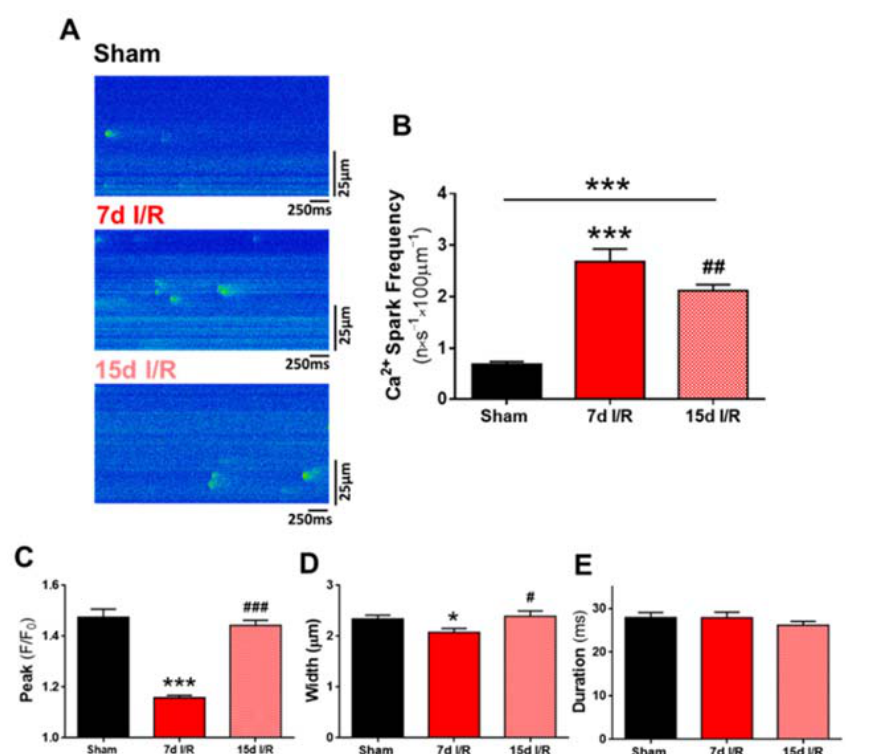
Figure 4. Diastolic Ca 2+ leak in cardiomyocytes after renal I/R. ( A ) Representative line-scan images of Ca 2+ sparks in quiescent cardiomyocytes from sham-treated mice and from mice subjected to ischemia and reperfusion (IR) for 7 and 15 days. ( B ) Frequency of Ca 2+ sparks (presented in n ∙ s − 1 ∙ 100 μ m − 1 ). ( C ) Mean peak of fluorescence Ca 2+ sparks (F/F 0 ). ( D ) Full width at half maximum of fluorescence of sparks ( μ m). ( E ) Full duration at half maximum of fluorescence Ca 2+ sparks (ms). Data are expressed as mean ± SEM. * p < 0.05, *** p < 0.001 versus sham; # p < 0.05, ## p < 0.01 versus and ### p < 0.001 versus 7d I/R. sham ( n = 57 cells, N = 10 mice), 7 d I/R ( n = 43 cells, N = 10 mice) and 15 d I/R ( n = 85 cells, N = 6 mice).